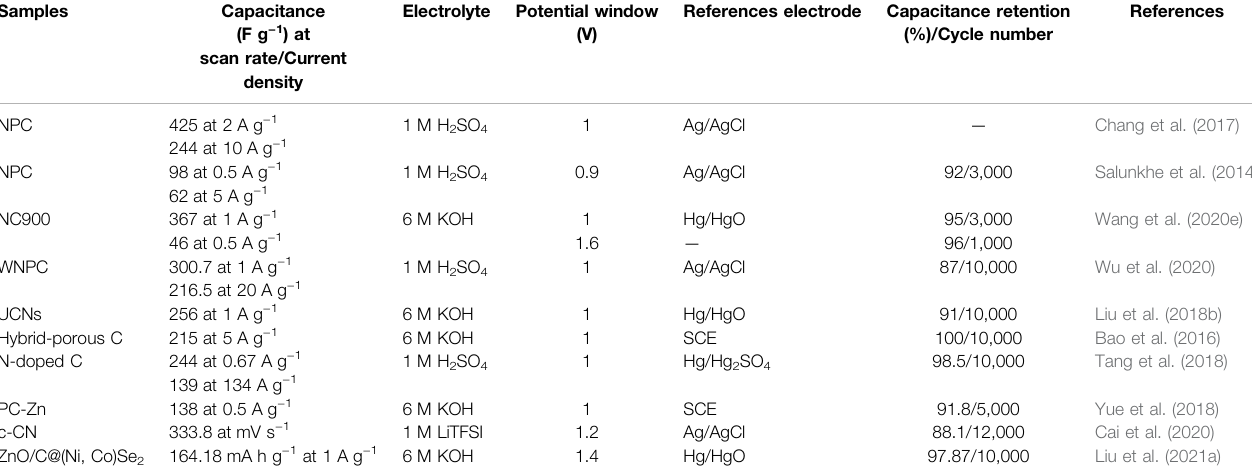
TABLE 2 | The summary of the electrochemical performance of MOF-derived carbon nanomaterials as electrode active materials for SCs.